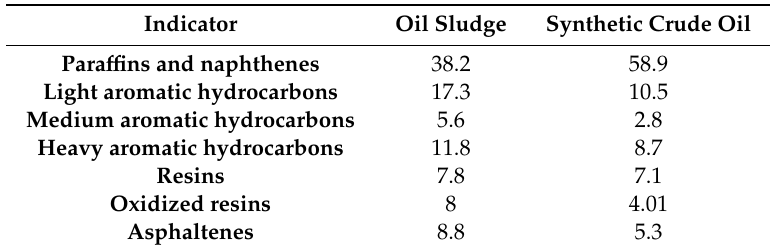
Table 6. Group composition of oil from oil phase III separated from